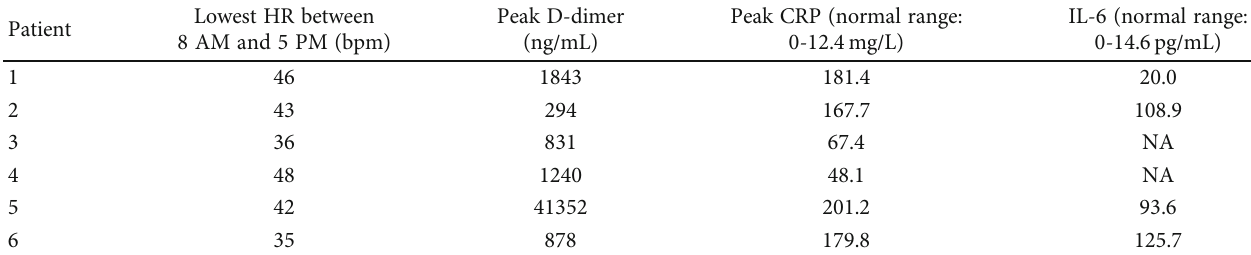
Figure 2: Average heart rate throughout hospitalization juxtaposed with remdesivir administration. Each patient ’ s average daily heart rate in beats per minute is juxtaposed in this fi gure with documented hospital days of remdesivir administration. Every patient received fi ve consecutive doses of remdesivir, starting on the fi rst full day of hospitalization unless otherwise noted in the case descriptions. The second documented day of hospitalization was the fi rst full day of hospitalization for patients who were admitted in the afternoon or evening of the day prior. The fi rst day and last days of administration as follows in a “ fi rst day/last day ” format: patient (1) 5/9, patient (2) 2/6, patient (3) 2/6, patient (4) 2/6, patient (5) 4/8, patient (6) 1/5. The threshold for bradycardia is noted, and the third day after the last dose of Remdesivir is noted. Recovery from bradycardia was expected at this point should remdesivir be causative. Table 2: Additional patient